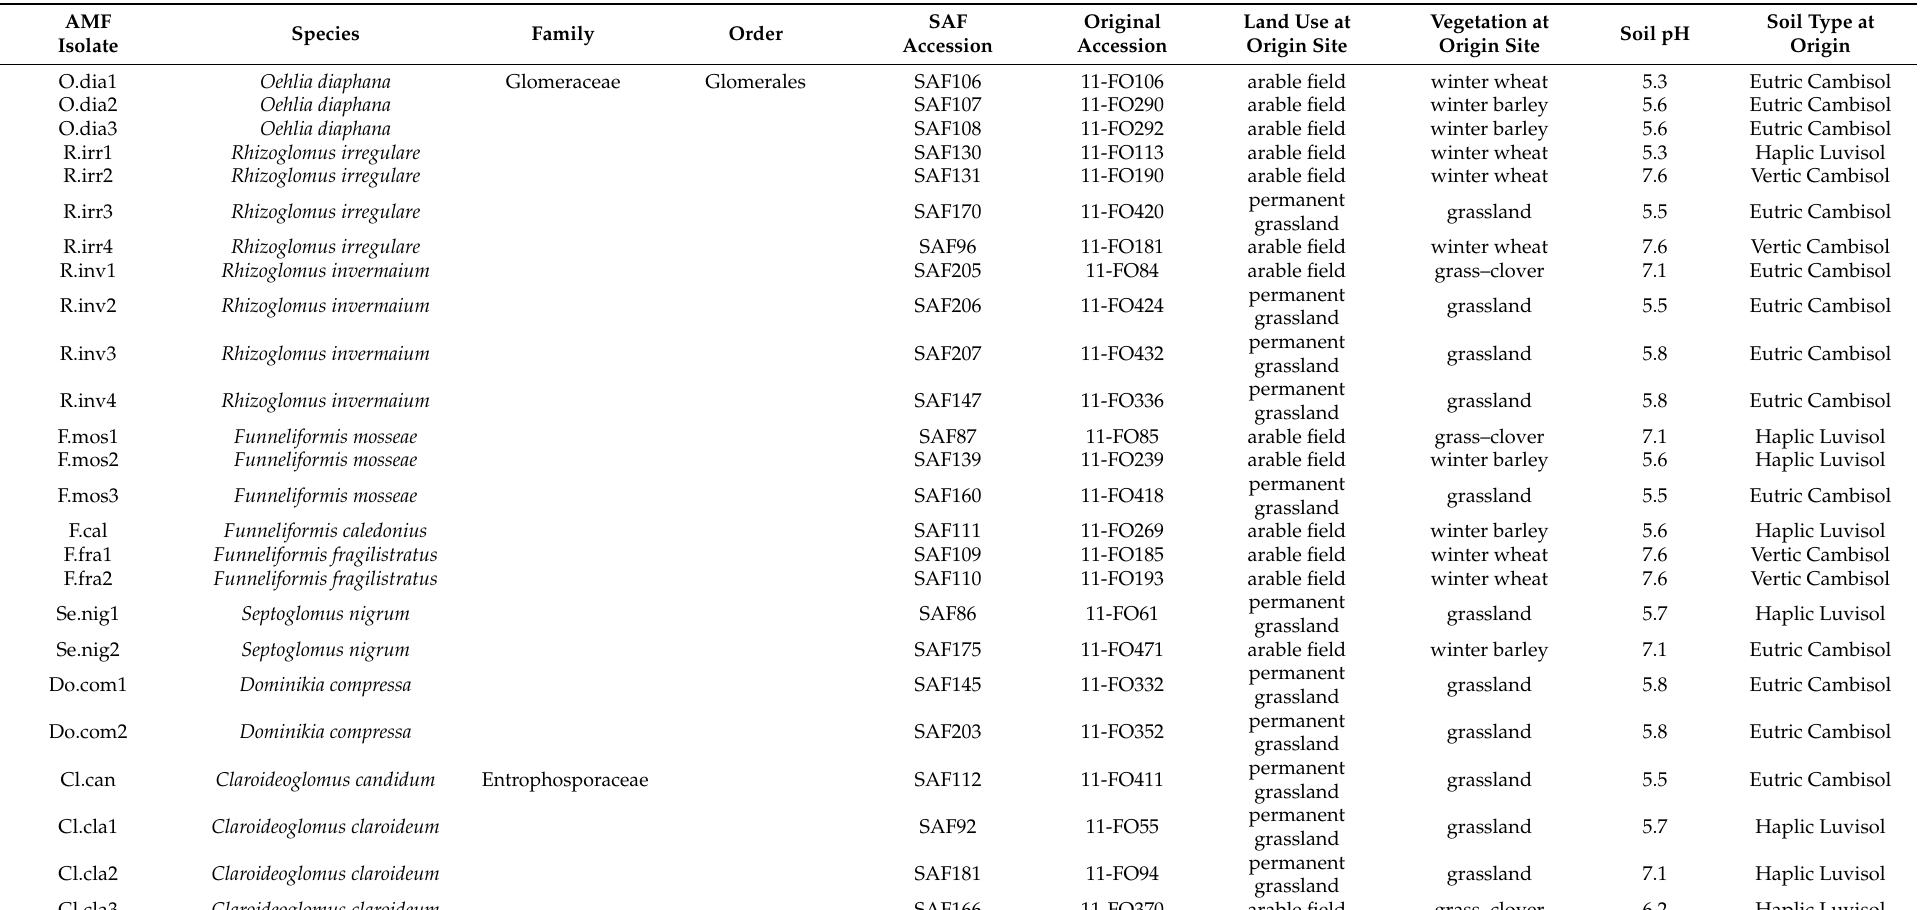
Table 3. List of AMF isolates of this study together with reference collection numbers (SAF = Swiss collection of arbuscular mycorrhizal fungi; original accession number) and information on the original isolation sites of the AMF isolates. Nomenclature is according to Oehl, et al. [41] and Oehl, et al. [42], updated in Baltruschat, et al. [43] and Wijayawardene, et al. [44]. Some isolates may be named differently by other authors (e.g.,